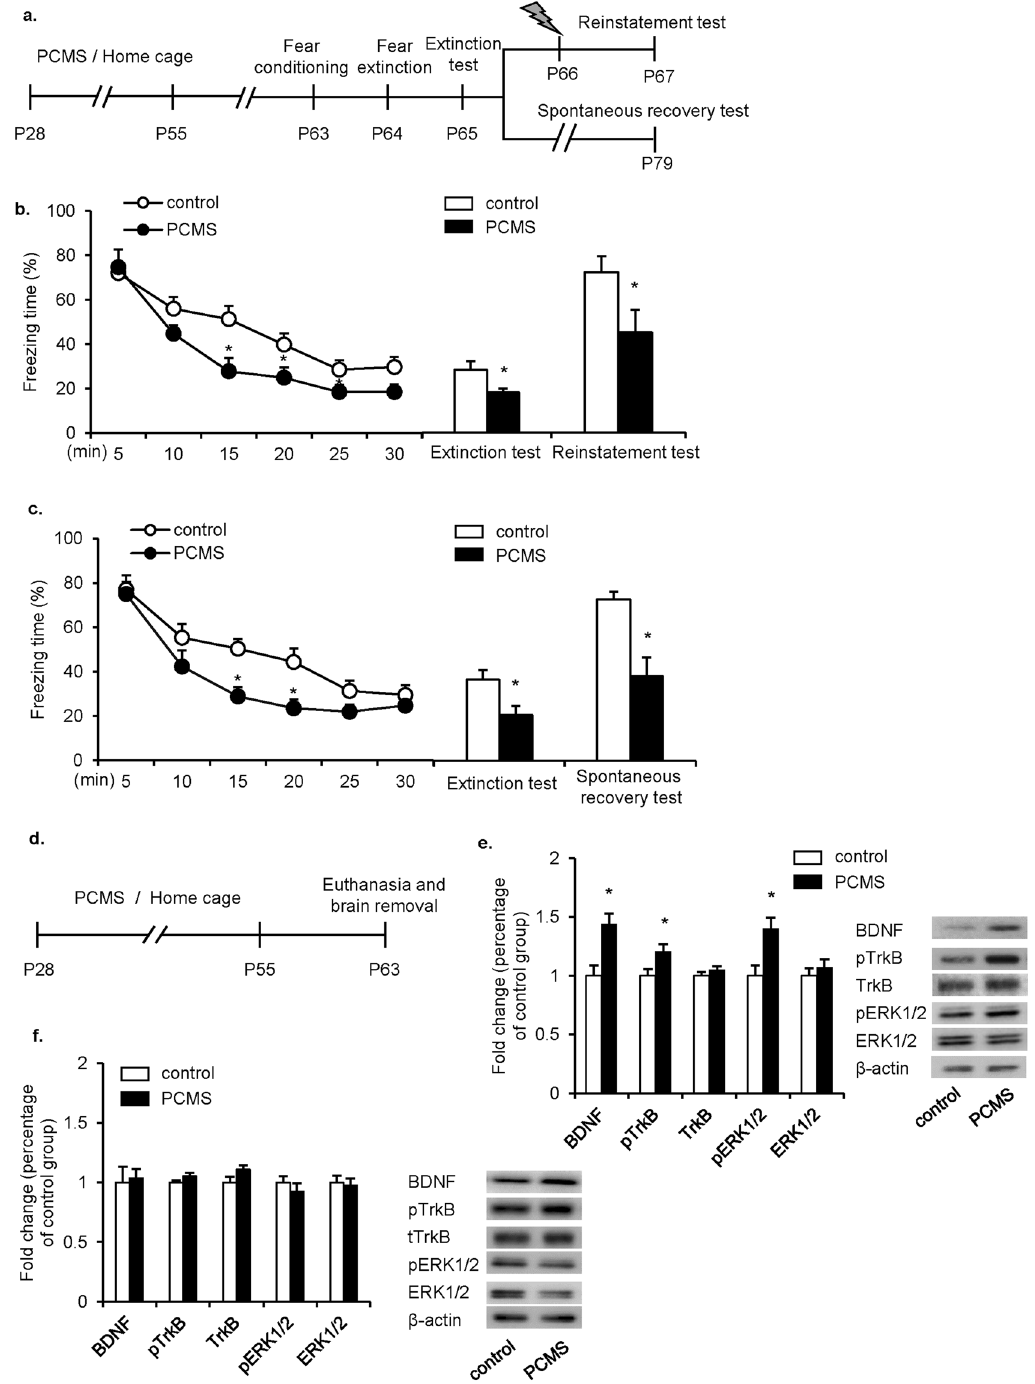
Figure 3. PCMS during adolescence had a prolonged extinction-enhancing effect. ( a , d ) Experimental timeline. ( b , c ) One week after adolescent PCMS exposure, the rats exhibited an acceleration of fear extinction and lower fear responses in the extinction test, reinstatement test, and spontaneous recovery test. ( b ) Fear responses were reduced in the extinction test and reinstatement test 1 week after PCMS exposure ( n = 7–9 per group). ( c ) Fear responses in the extinction test and spontaneous recovery test were reduced 1 week after PCMS exposure ( n = 7–9 per group). ( e , f ) Protein levels and representative western blot bands of BDNF, pTrkB, TrkB, pERK1/2, and ERK1/2 in the IL ( e ) and PrL ( f ) in PCMS-exposed and control rats ( n = 8–10 per group). Blots shown are cropped from full-length. The data are expressed as the mean ± SEM. * p < 0.05, compared with the control